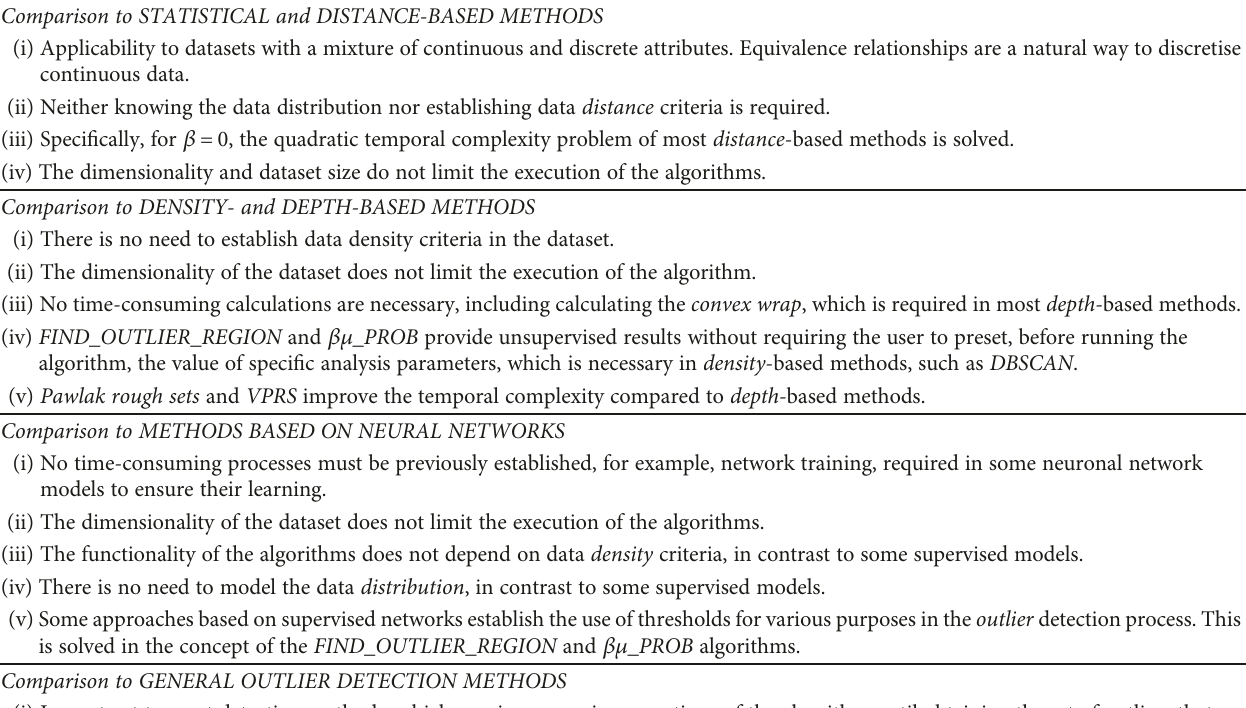
Table 4: Characteristics of the RS-based methods compared to the limitations of conventional methods.